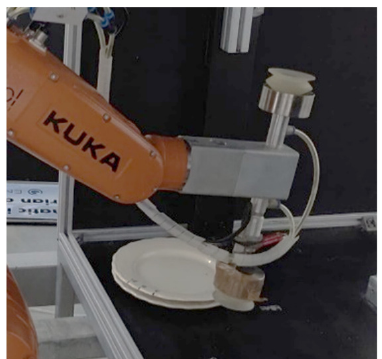
Figure 1. Dual gripper.